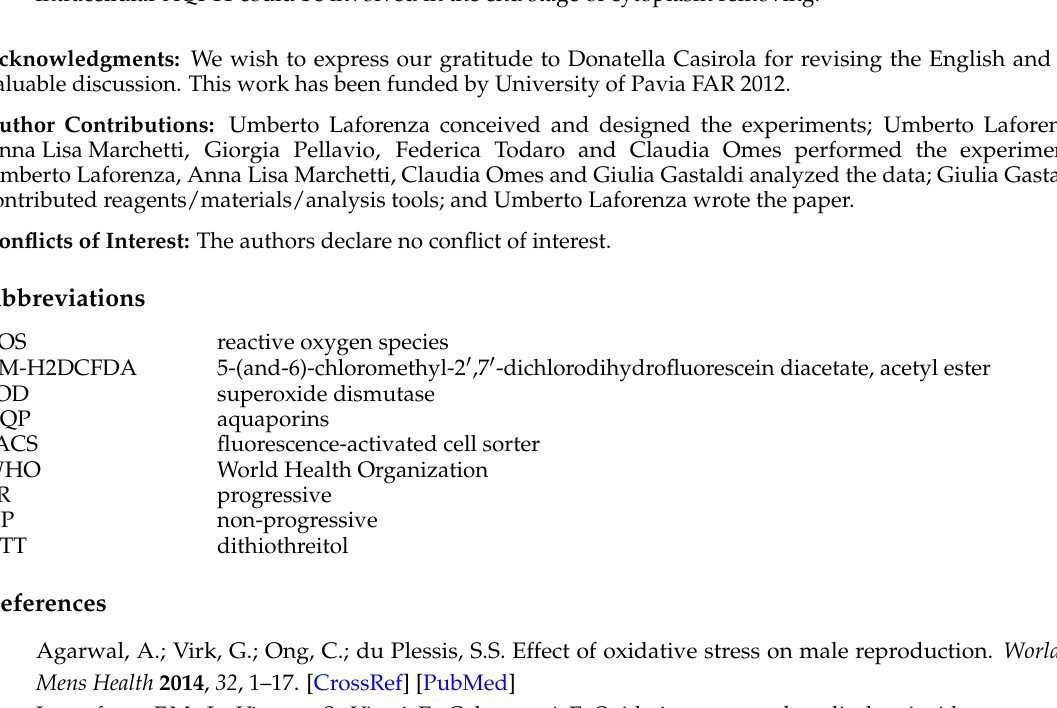
Figure 7. Schematic model of aquaporins (AQP) functioning under normal and oxidative stress conditions: ( A ) under normal condition, water enters through AQP7 and exits through AQP3. H 2 O 2 produced in low amount exits from mitochondria through AQP8; and ( B ) under oxidative stress condition, H 2 O 2 reduces water inflow and outflow through AQP7 and AQP3, thus affecting sperm motility. H 2 O 2 reduces also AQP8 permeability that hampers H 2 O 2 wasting; this leads to H 2 O 2 accumulation into mitochondria, reduced AQP production and thus to reduced sperm motility. Intracellular AQP11 could be involved in the end stage of cytoplasm removing.